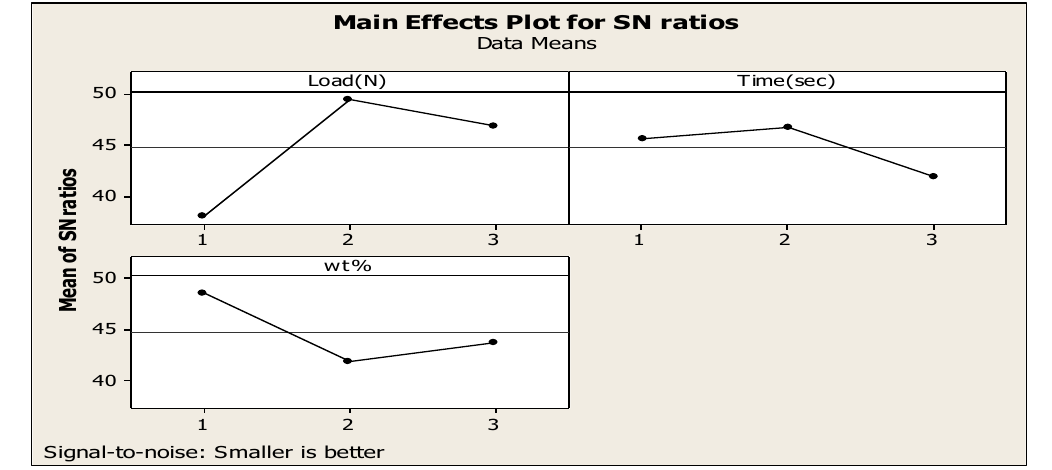
Main Effects Plot for SN ratios Data Means